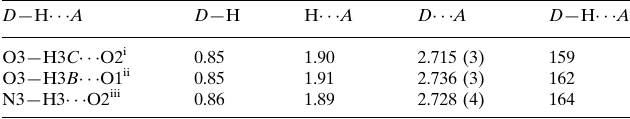
Hydrogen-bond geometry (A˚ , (cid:2)